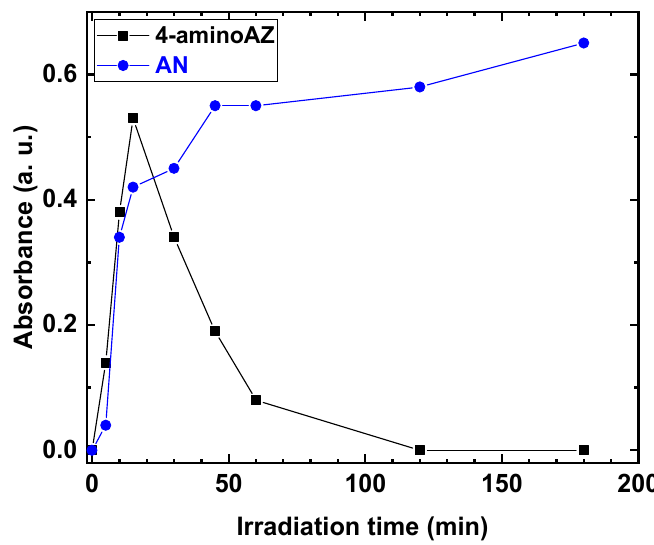
Figure 6. Absorbance of 4-aminoAZ and AN as a function of irradiation time. As the dosage of TiO 2 (P25) increased from 0.5 g/L to 3 g/L, the NB yield